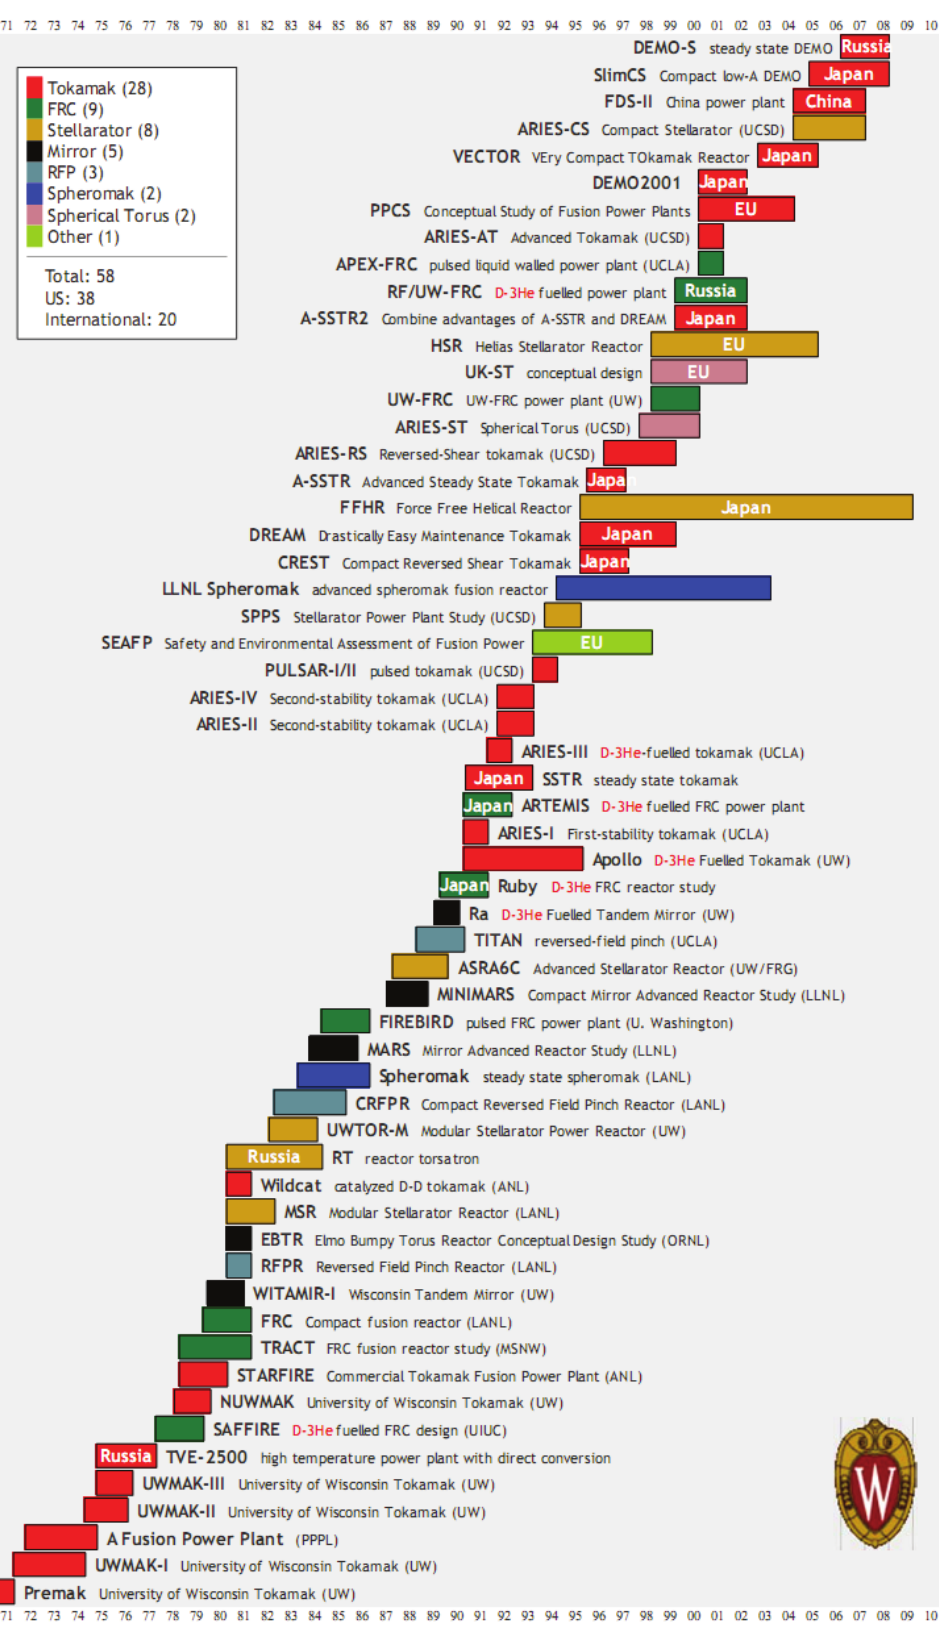
Figure 1. Timeline of large-scale conceptual power plant designs developed in the US (38–unmarked) and abroad (20–marked) for magnetic fusion